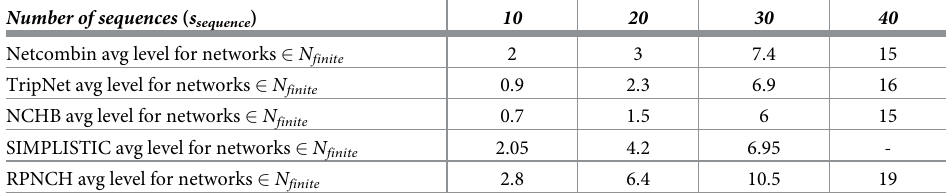
Table 4. The average level results for the networks that belong to N TIC, and RPNCH. Number of sequences ( s sequence